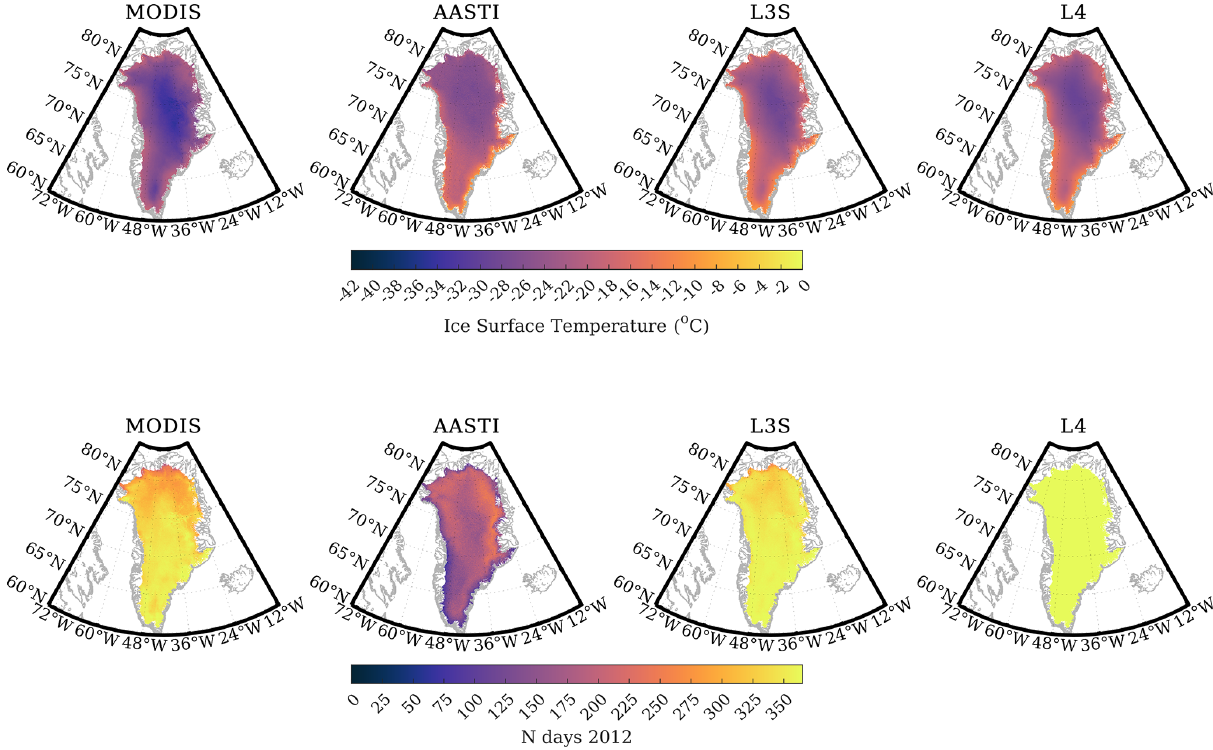
Figure 5. Mean IST over the Greenland Ice Sheet in 2012 from the L3 MODIS, L3 AASTI, and derived L3S and L4 IST products (top) along with the number of days used to derive the mean